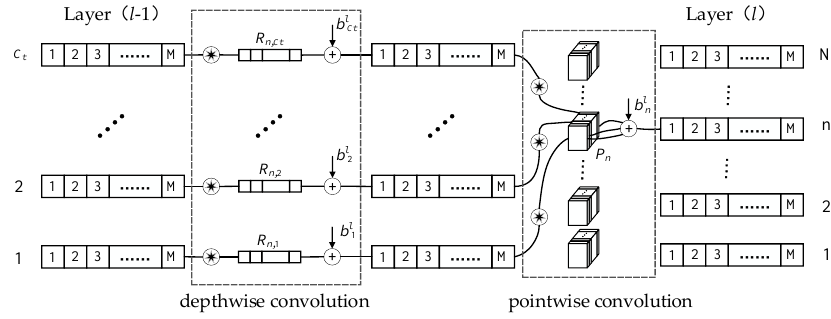
Figure 5. Illustration of DSC module.